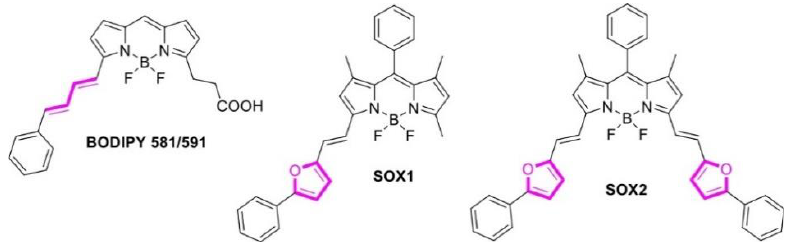
Figure 2. Structures of some BODIPY derivatives that can be used as sensors for 1 O 2 . ROS binding sites are marked with magenta.